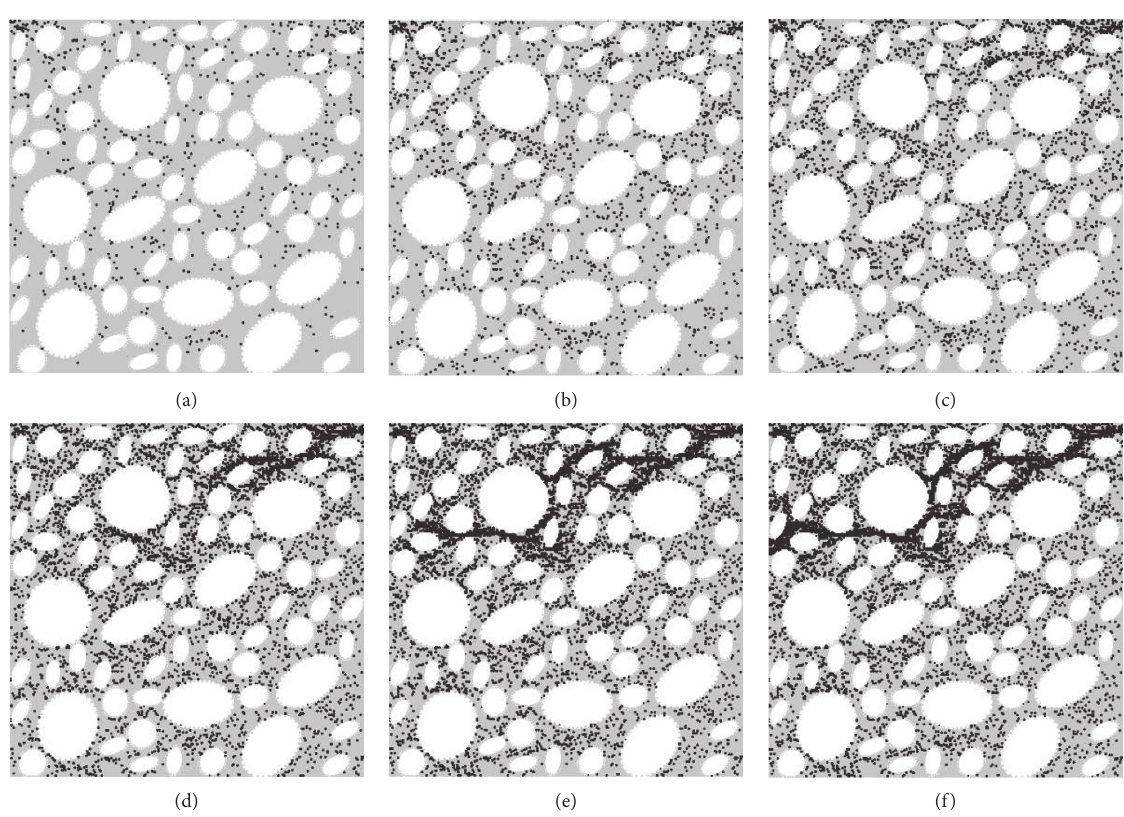
Figure 6: Mesoscale damage evolution process of the specimen under uniaxial tension. White and light-gray colors represent aggregates and mortar matrix, respectively, and dark-gray and black colors denote shear failure and tension failure,